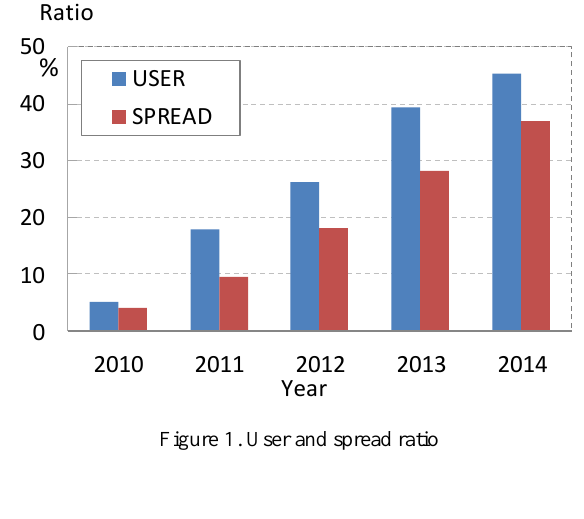
Figure 1. User and spread